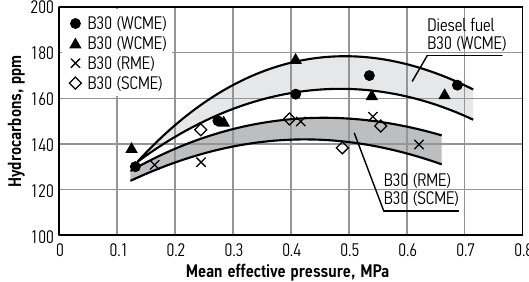
Fig. 12. The dependence of the carbon dioxide (CO 2 ) emission of 1Z diesel engine on mean effective pressure P